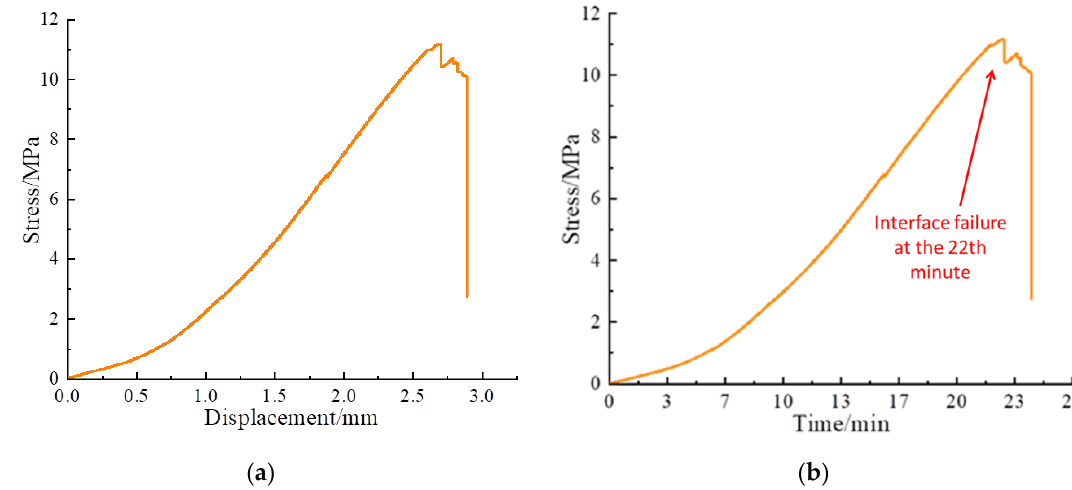
Figure 9. Shear test curve of Composite specimen I: ( a ) Shear stress-displacement curve; ( b ) Shear stress-time curve.